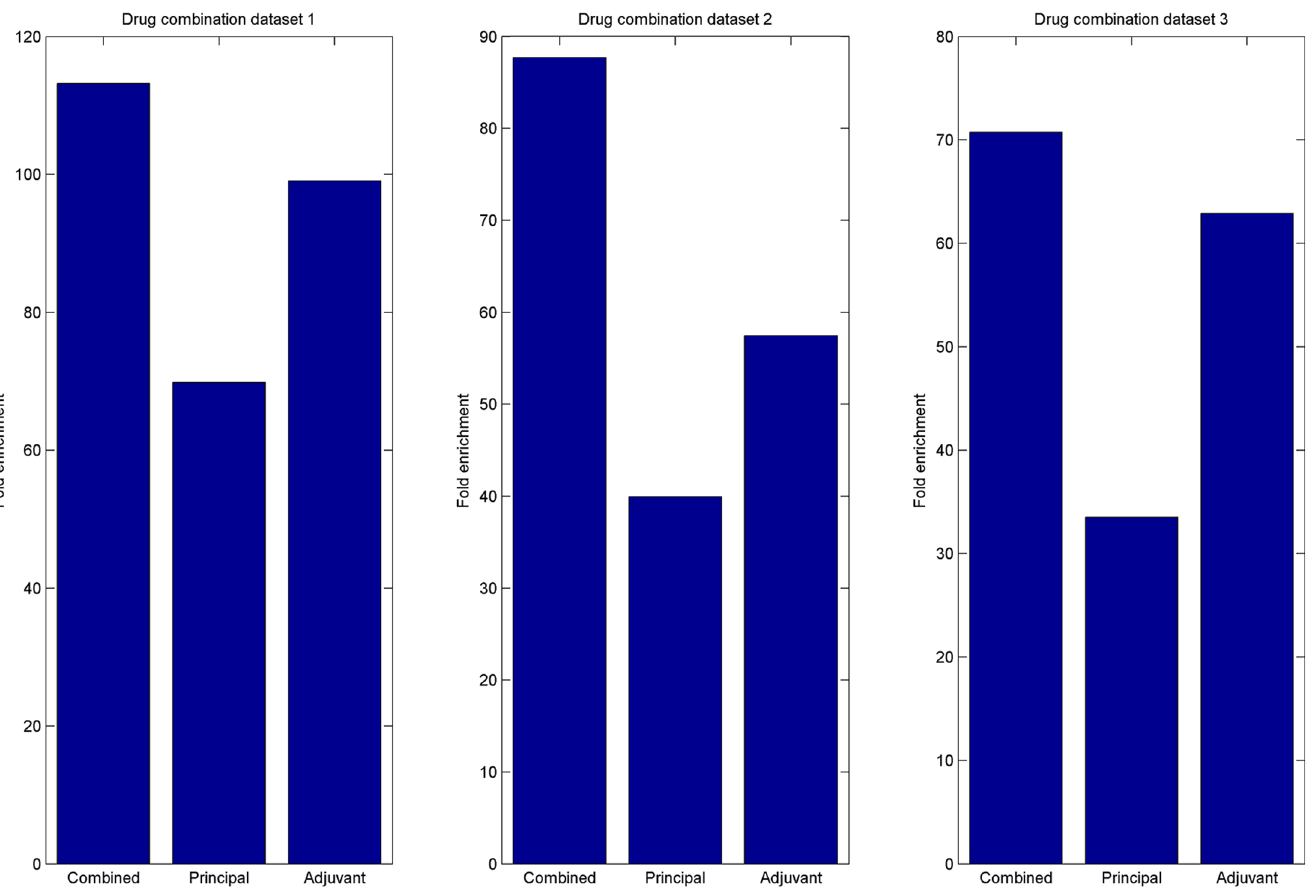
Fig 5. LOOCV was implemented in three antifungal synergistic drug combinations datasets. Fold enrichment score was calculated to evaluate the performance of the method. Here known synergistic drug combinations were used as a test dataset. The fold enrichment score of NLLSS based on the combination of two classifiers and based only on a single classifier were compared. The results confirmed the performance advantage of combining the classifiers in the principal and adjuvant drug space into a single classifier.